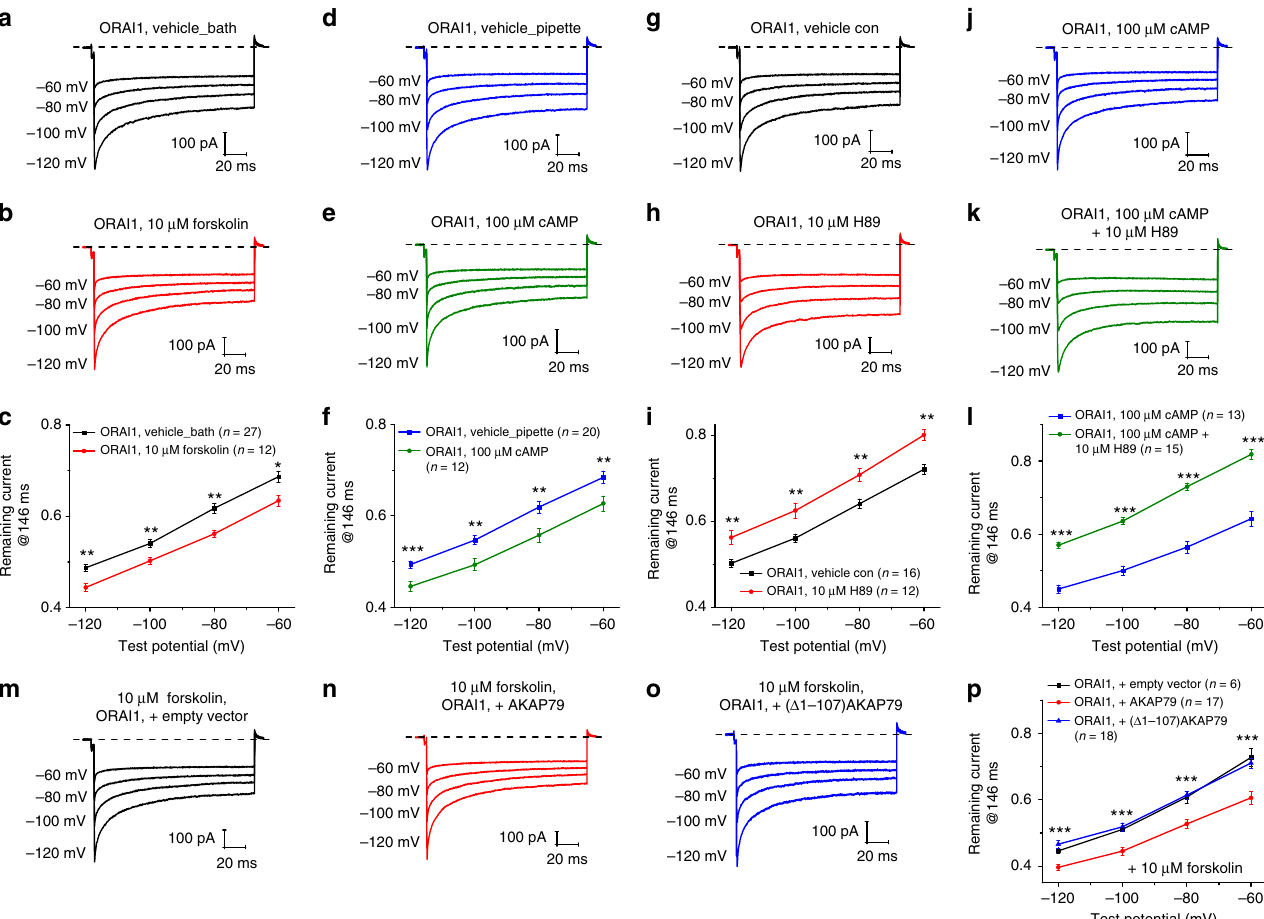
Fig. 3 ORAI1 CDI requires cAMP and PKA. a – c Representative currents from ORAI1-KO cells co-expressing eYFP-STIM1 with ORAI1-CFP and treated in the bath with either a vehicle or b Forskolin (10 µ M). c The extent of ORAI1 CDI from ( a ) and ( b ) represented as current remaining at 146 ms. Each data point represents mean ± SEM. d – f Representative currents from ORAI1-KO cells co-expressing eYFP-STIM1 with ORAI1-CFP and dialyzed through patch pipette with either d vehicle or e cAMP (100 µ M). f The extent of ORAI1 CDI from ( d ) and ( e ) represented as current remaining at 146 ms. Each data point represents mean ± SEM. g – i Representative currents from ORAI1-KO cells co-expressing eYFP-STIM1 with ORAI1-CFP and treated in the bath with either g vehicle or h PKA inhibitor (10 µ M). i The extent of ORAI1 CDI from ( g ) and ( h ) represented as current remaining at 146 ms. Each point represents mean ± SEM. j – l Representative currents from ORAI1-KO cells co-expressing eYFP-STIM1 with ORAI1-CFP dialyzed with cAMP (100 µ M) through the patch pipette and treated in the bath with either j vehicle or k PKA inhibitor (10 µ M). l The extent of ORAI1 CDI from ( j ) and ( k ) represented as current remaining at 146 ms. Each data point represents mean ± SEM. m – p Representative currents from ORAI1-KO cells co-expressing eYFP-STIM1 with ORAI1-CFP stimulated with Forskolin (10 µ M) and expressing either m an empty vector, n full-length AKAP79, or o Δ 1-107AKAP79. p The extent of ORAI1 CDI from ( m ), ( n ), and ( o ) represented as current remaining at 146 ms. Each data point represents mean ± SEM. * p < 0.05, ** p < 0.01, *** p < 0.001, two-tailed Student ’ s t test was used for ( c , f , i , l ), and one-way ANOVA for ( p